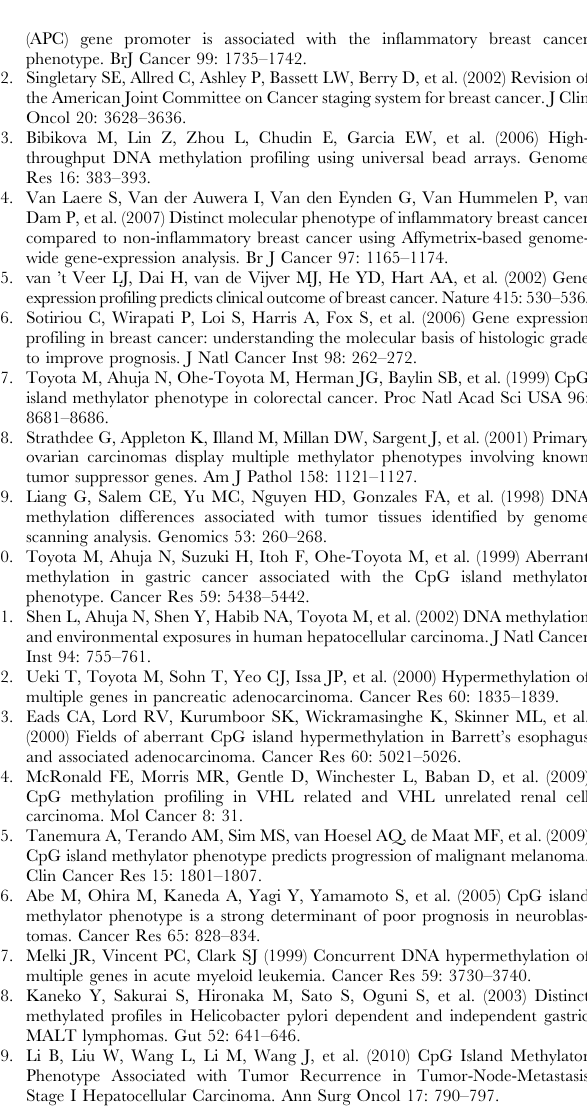
Figure S1 Box plots of mRNA expression levels for DNMT3B and DNMT1 in the high b and low b groups of breast tumors. In the high b group of breast tumors, higher mRNA expression levels for DNMT3B and DNMT1 were observed in comparison to the low b group of breast tumors. Figure S2 Results of PAM analysis. The 62 breast tumor samples (x-axis) are plotted against the probabilities to belong to either class high b (green) or low b (red). For each sample, two small circles are plotted: the red one showing the probability that this sample belongs to the low b group of breast tumors and the green one that it belongs to the high b group of breast tumors. The classifier correctly predicted 47 of 49 low b and 13 of 13 high b samples for an overall success rate of 97%. Figure S3 Box plots of methylation levels in the low b and high b groups of breast tumors for the 16 CpG loci belonging to the classifier identified by PAM